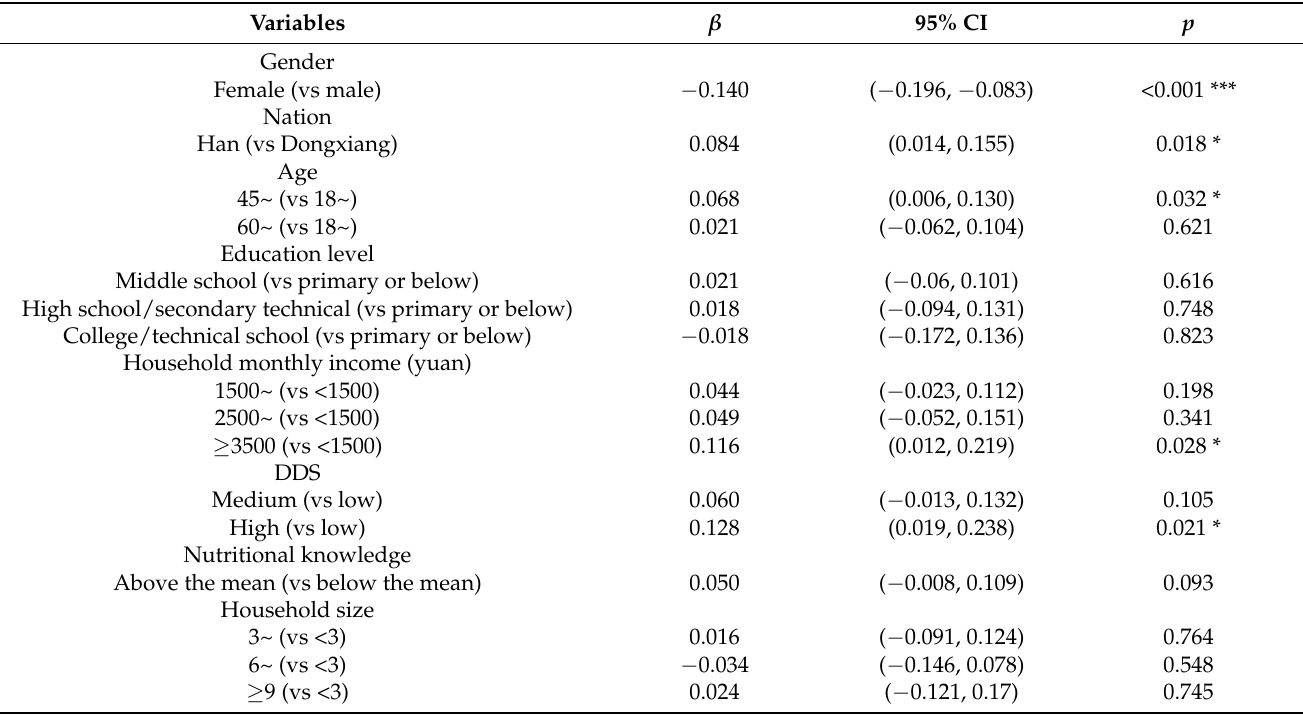
Table 6. Linear regression model on predictors of MAR among smallholder farmers ( N =